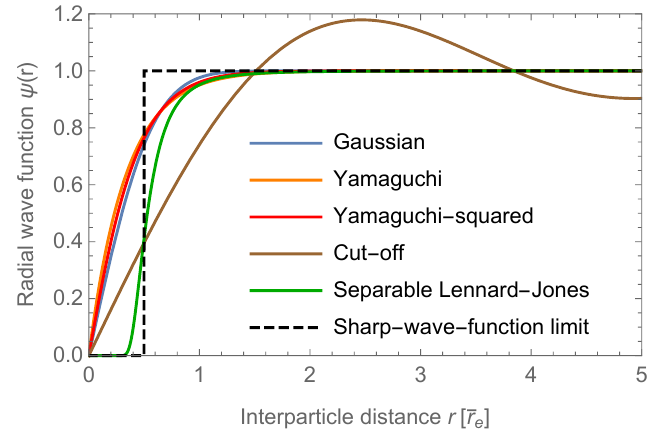
Figure 3: S-wave radial two-body wave function at zero energy obtained for different models at the s-wave resonance ( | a | → ∞ ) - see Table 1 and main text. The wave function is normalised to tend to unity asymptotically, and the distance is expressed in units of the effective range at resonance ¯ r e